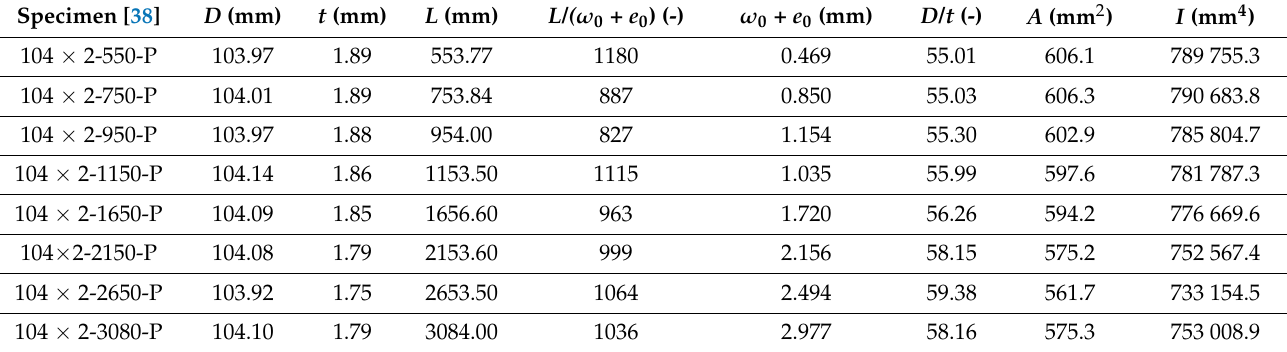
Table 4. Measured and calculated geometric properties of the cross-section set 104 × 2 CHS pin-ended columns (austenitic steel).